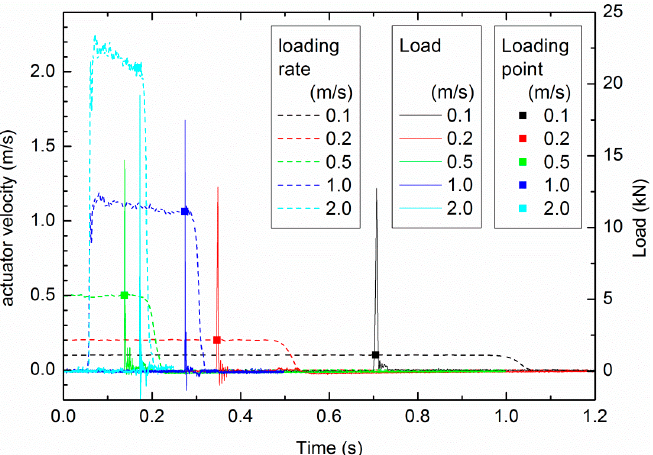
Figure 4. Schematic sketch of the dynamic loading system and image acquisition system. Two-load-cell monitoring system is shown in the lower right corner.